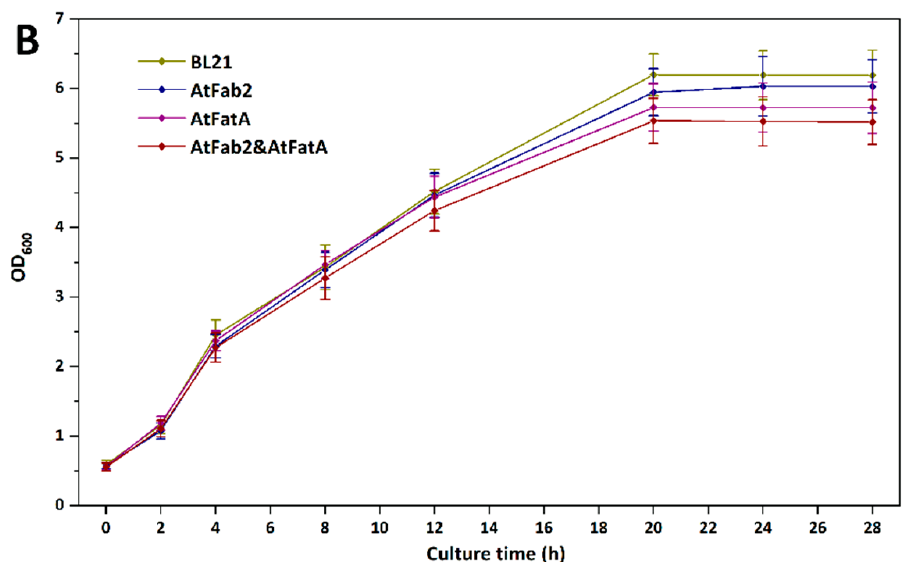
Figure 4. Effects of heterologous expression of AtFab2 and AtFatA on cell growth at different temperature. OD 600 values were determined after being induced by IPTG. ( A ), growth curves of different strains at 37 ◦ C; ( B ), growth curves of different strains at 30 ◦ C. BL21, E. coli BL21(DE3) harboring pET30a(+); AtFab2, E. coli BL21(DE3) harboring pET-AtFab2; AtFatA, E. coli BL21(DE3) harboring pACYC-AtFatA; AtFab2&AtFatA, E. coli BL21(DE3) harboring both pET-AtFab2 and pACYC-AtFatA. For the identification of fatty acids in E. coli by gas chromatography, mass spectrometry was performed in our previous study [29]. The fatty acid compositions of E. coli varied with the growth stages. Myristic acid, palmitic acid, palmitoleic acid and cis-vaccenic acid made up of the main fatty acid components in E. coli membrane lipids at the logarithmic phase. However, these two unsaturated fatty acids, palmitoleic acid and cis-vaccenic acid, were catalyzed by cyclopropane fatty acid synthetase to form methylene-9,10-hexadecanoic acid and methylene-11,12-octadecanoic acid during the transition from the logarithmic phase to the stationary phase. To avoid cyclopropane fatty acids formation, cultures of different recombinant E. coli strains were induced earlier at an OD 600 of 0.3–0.4 and cells were harvested by centrifugation 3 h after induction (OD 600 ≈ 1.0). Figure 5 shows the GC chromatograms of FAMEs from different recombinant strains and Table 2 shows the percentages of different fatty acids in different strains. The amount of each fatty acid was calculated according to the area of its peak. Our results indicated that different recombinant strains revealed different fatty acid compositions. Palmitic acid level of the control strain harboring the empty vector pET30a(+) reached 44.7 ± 1.0%, and the ratio of UFA (palmitoleic acid + cis-vaccenic acid) to saturated fatty acid (SFA, myristic acid + palmitic acid) was about 1:1 in this strain. For the recombinant strain carrying pET-AtFab2, palmitic acid content decreased to 34.4 ± 0.8% and the percentage of cis- vaccenic acid increased to 42.9 ± 0.8%. When the AtFatA gene was expressed separately, the recombinant strain overproduced palmitoleic acid. The level of this UFA was much higher (35.6 ± 0.6%) when compared with the control strain). For the strain co-expressing AtFab2 and AtFatA simultaneously, the percentage of palmitic acid further decreased to 29.6 ± 1.0%. Additionally, the ratio of UFA to SFA reached 2:1 in this recombinant